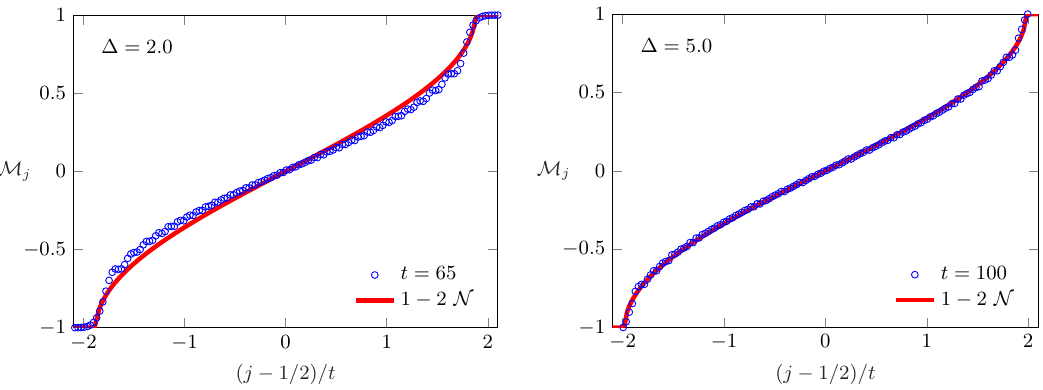
( t ) obtained from tDMRG calcula- j in a 1